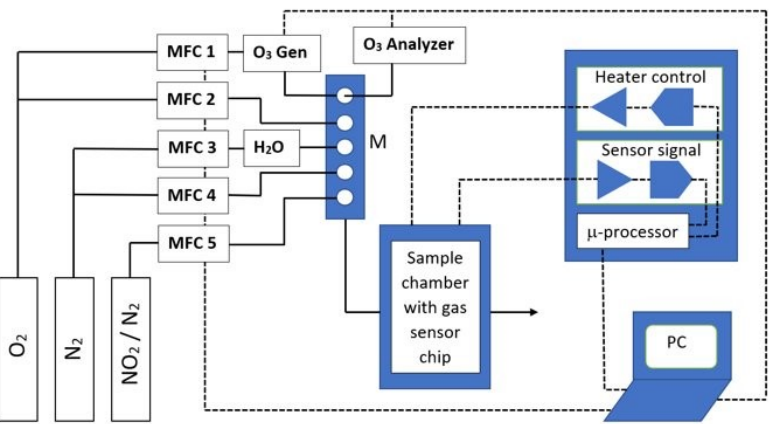
Figure 2. The experimental setup used for gas sensitivity measurements. MFC—mass flow control- M—gas mixer, O 3 Gen—ozone generator, H 2 O—water ler, M—gas mixer, O 3 Gen—ozone generator, H 2 O—water bubbler.